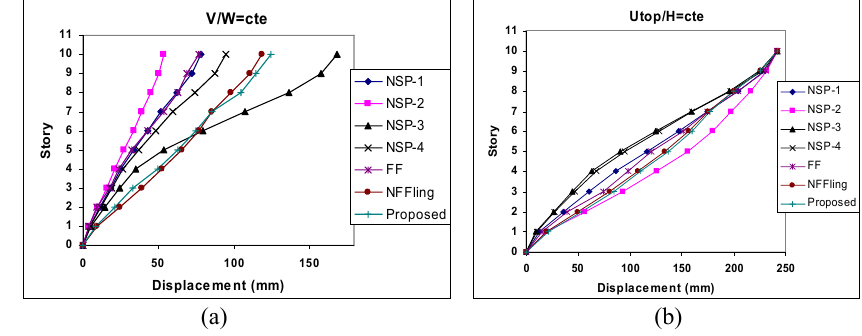
Figure 10. Peak displacement profiles for the 3-storey building with (a) V/W=cte, (b) U top /H=cte